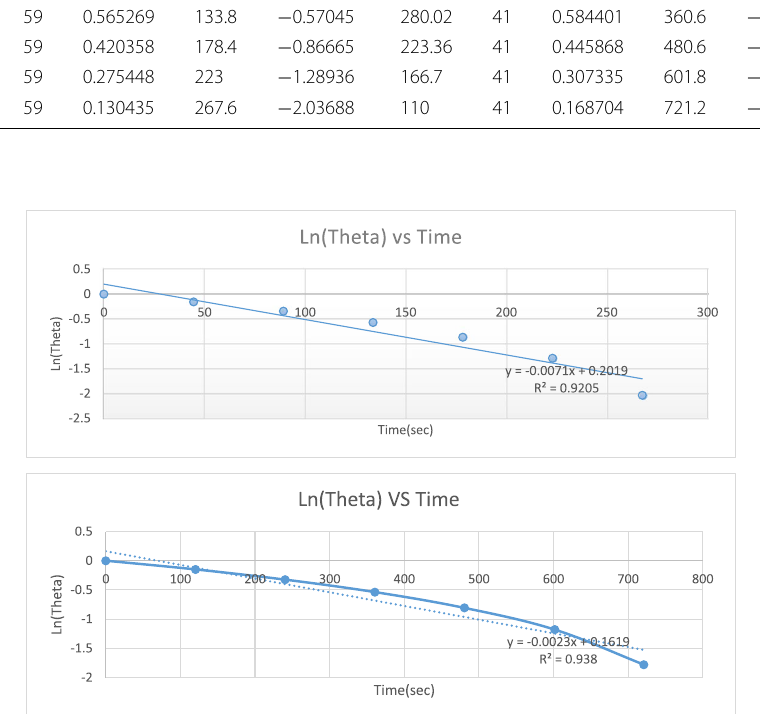
40 mm, (top) for W-JIC and (bottom) for A-JIC =